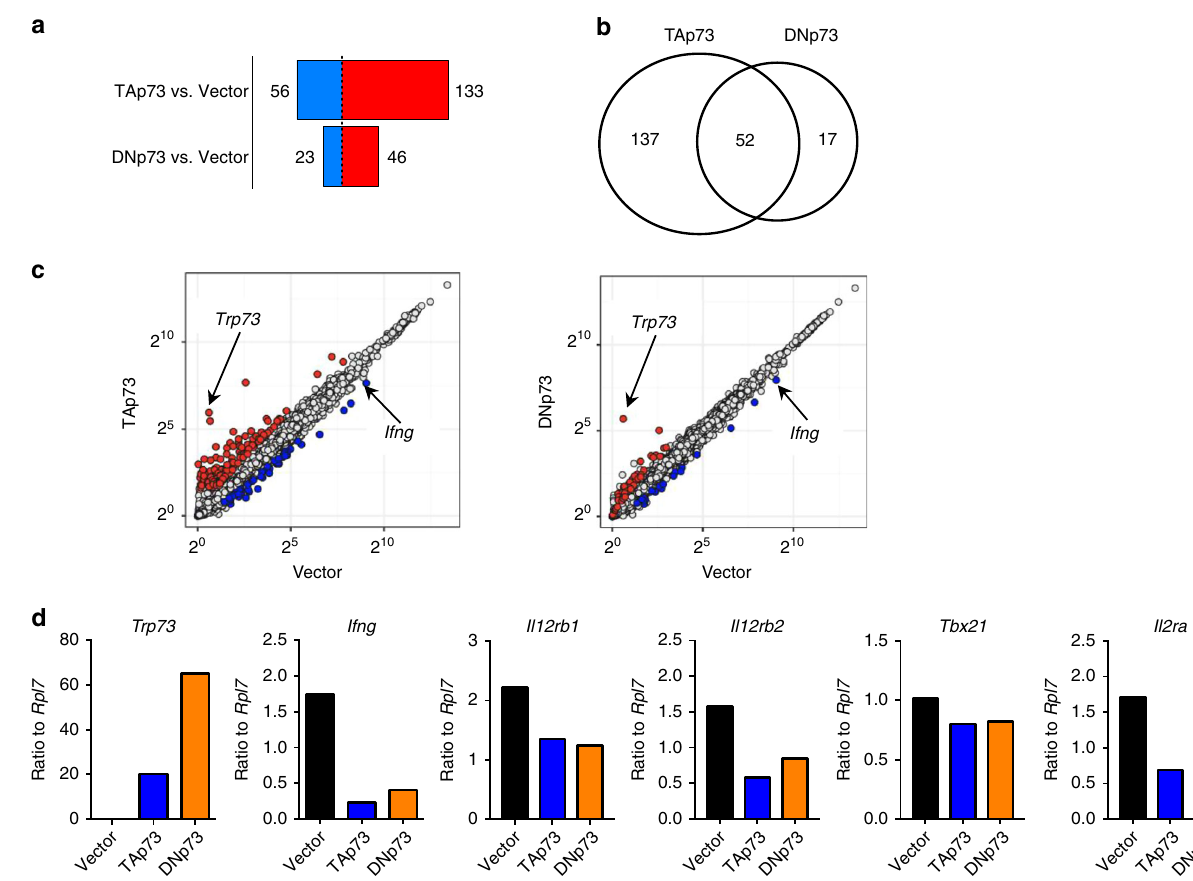
Fig. 3 Gene expression analysis of Th1 cells transduced with TAp73 or DNp73 constructs. a – d Empty vector (Vector), TAp73, or DNp73 were expressed in Th1 cells via retroviral transduction. Transduced cells were identi fi ed as GFP + and enriched by cell sorting. mRNA was isolated from GFP + cells and analyzed by RNA-Seq. a Number of differentially expressed genes (fold change ≥ 2 and FDR < 0.05) in TAp73 versus vector and DNp73 versus vector. Upregulated genes are in red and downregulated genes are in blue. b Venn diagram showing genes differentially expressed by TAp73 or DNp73 versus vector control, with 52 genes in the intersection area, of which 37 were induced by both TAp73 and DNp73, 14 were repressed by both, and Lmo2 was inhibited by TAp73 but induced by DNp73. c Genes induced and repressed ( ≥ 2-fold difference; FDR < 0.05) in TAp73 or DNp73 transduced Th1 cells compared to vector alone. The Log 2 (RPKM + 1) values were plotted and shown as scatter plots. Differentially expressed genes ( ≥ 2-fold difference; FDR < 0.05) are shown as open circles in red (higher expression) or blue (lower expression) with TAp73 (left panel) or DNp73 (right panel). d Experiments were performed as in a – c ; shown are mRNA expression levels of Trp73 , Ifng , Il12rb1 , Il12rb2 , Tbx21 , and Il2ra normalized to Rpl7 in cells transduced with TAp73 or DNp73. mRNA levels were measured by qRT-PCR from three independent experiments, and representative results are shown. Source data for d are provided in a Source Data